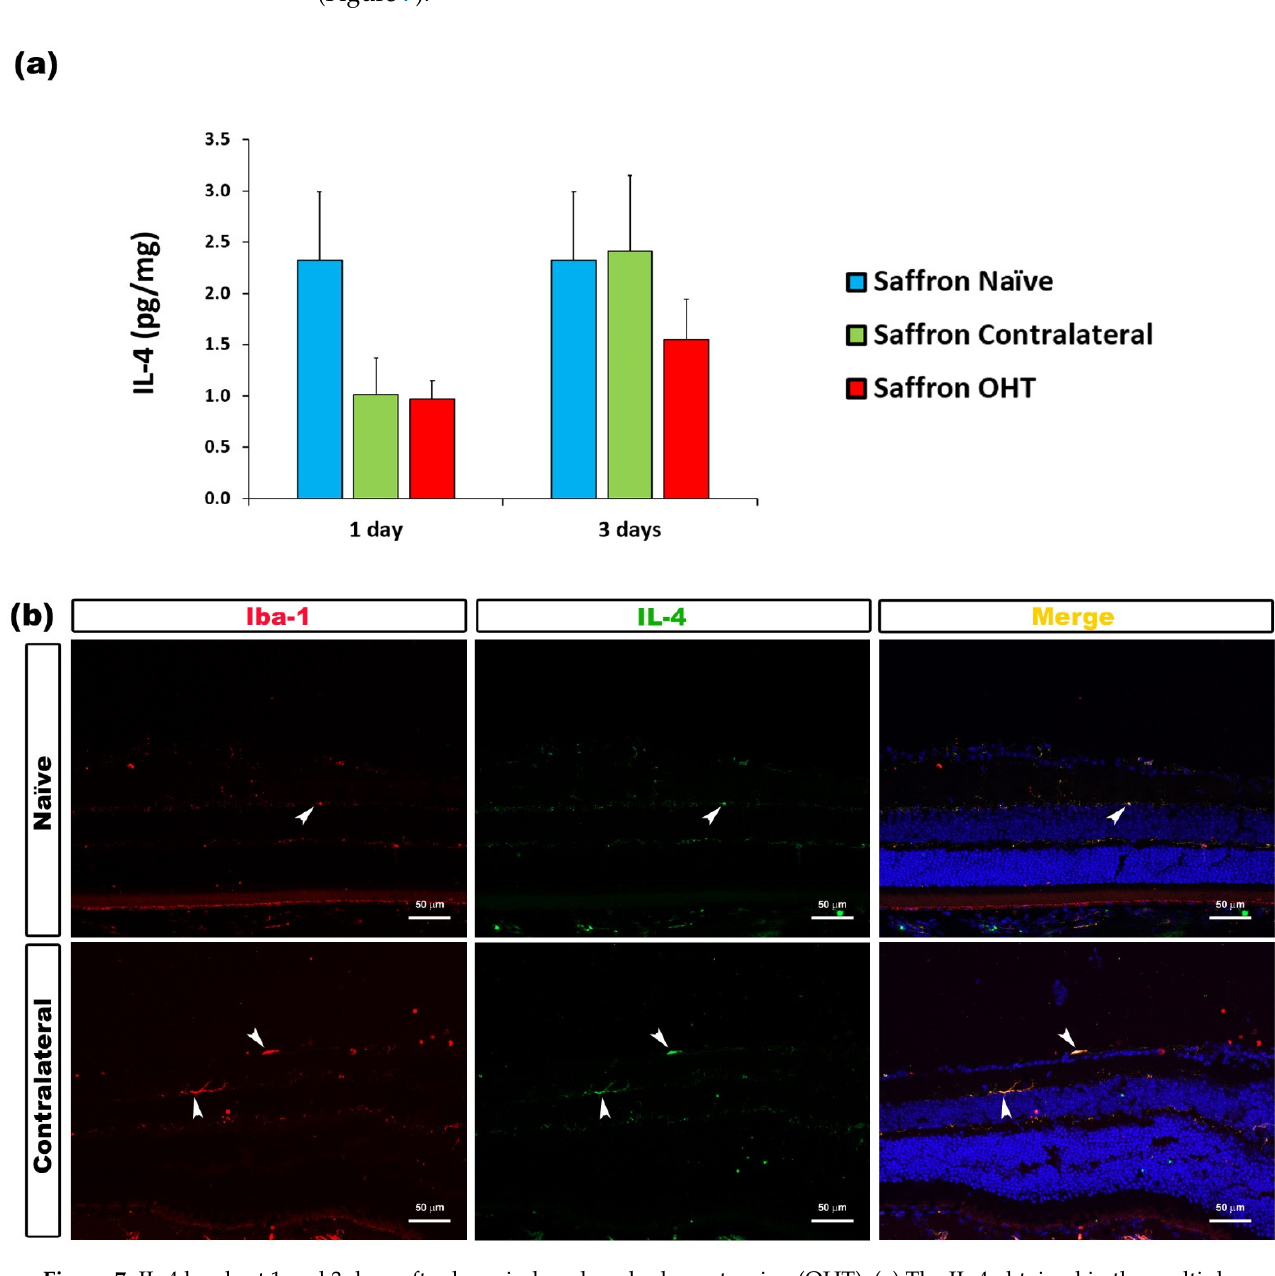
Figure 7. IL-4 levels at 1 and 3 days after laser-induced ocular hypertension (OHT). ( a ) The IL-4 obtained in the multiplex assay. The histogram shows the mean levels ( ± SD) of IL-4 (pg/mg) at days 1 and 3 after laser OHT induction in saffron ocular hypertension eyes (saffron OHT) and saffron-contralateral eyes (saffron-contralateral) as well as in naïve eyes. ( b ) Immunohistochemical study of IL-4 expression in saffron-contralateral eyes three days after unilateral laser-induced OHT. Retinal sections were immunolabeled with antibodies to IL-4 (green) and Iba-1 (red). Merge is denoted by the colour yellow. The arrowhead shows the co-expression of Iba-1 and IL-4 in saffron-contralateral and saffron-naïve eyes. Abbreviations: OHT (ocular hypertension); IL-4 (interleukin- 4); Iba-1 (ionized calcium-binding adaptor molecule). ences were found. IL-10 expression was not altered in saffron OHT and saffron